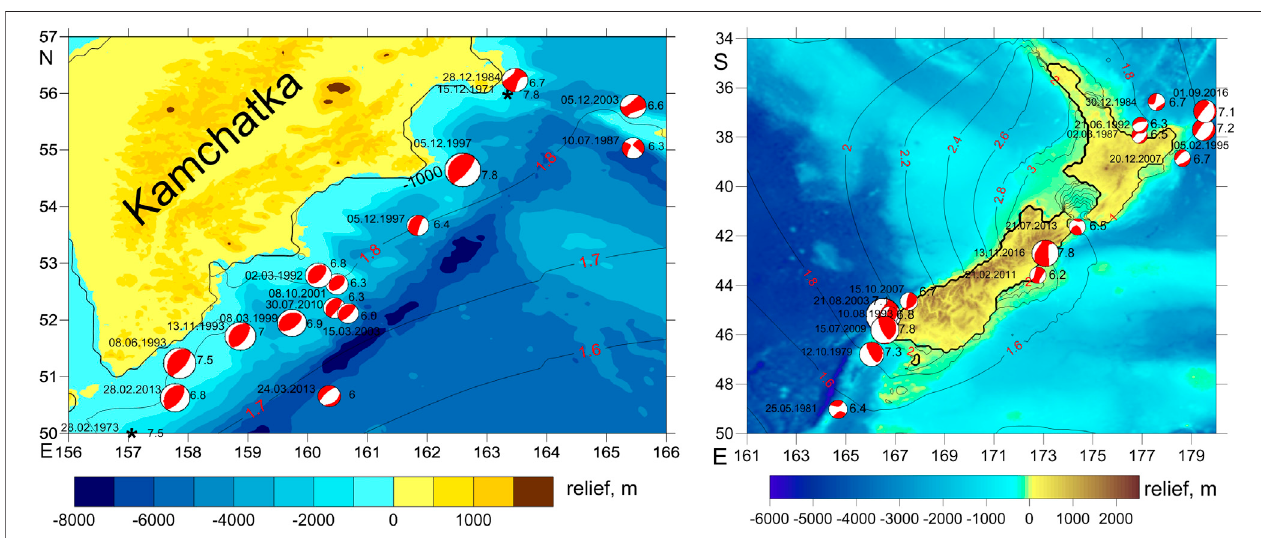
FIGURE6| Mapsof M ≥ 6mainshocksforKamchatka,1971 – 2013 (A) andNewZealand,1979 – 2016 (B) .Thecolourscaleshowstherelief(m)withrespecttosea level;black contours with red labelsshow maximum amplitude ofthe ocean tide,m. Themainshockfault-plane solutionswere takenfrom theGlobalCentroid-Moment- Tensor catalogue (Ekström et al., 2012); epicentres prior to 1976 are not reported in Global Centroid-Moment-Tensor, and they are marked by asterisks.